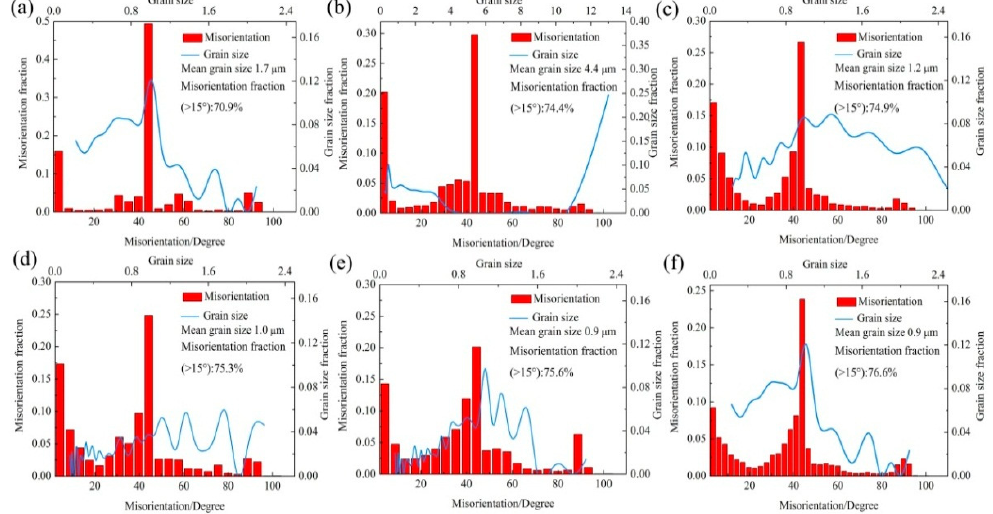
Figure 6. Misorientation fraction and grain size distribution of the as-rolled and can-compressed samples subject to annealing treatment: ( a ) as-rolled, ( b ) 25%, ( c ) 50%, ( d ) 60%, ( e ) 65%, and ( f ) 75%.